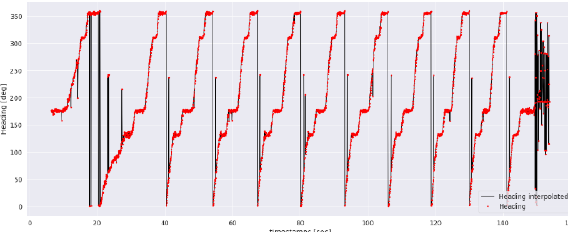
Figure 7. Interpolation of the prism headings: original (red) and interpolated (black)